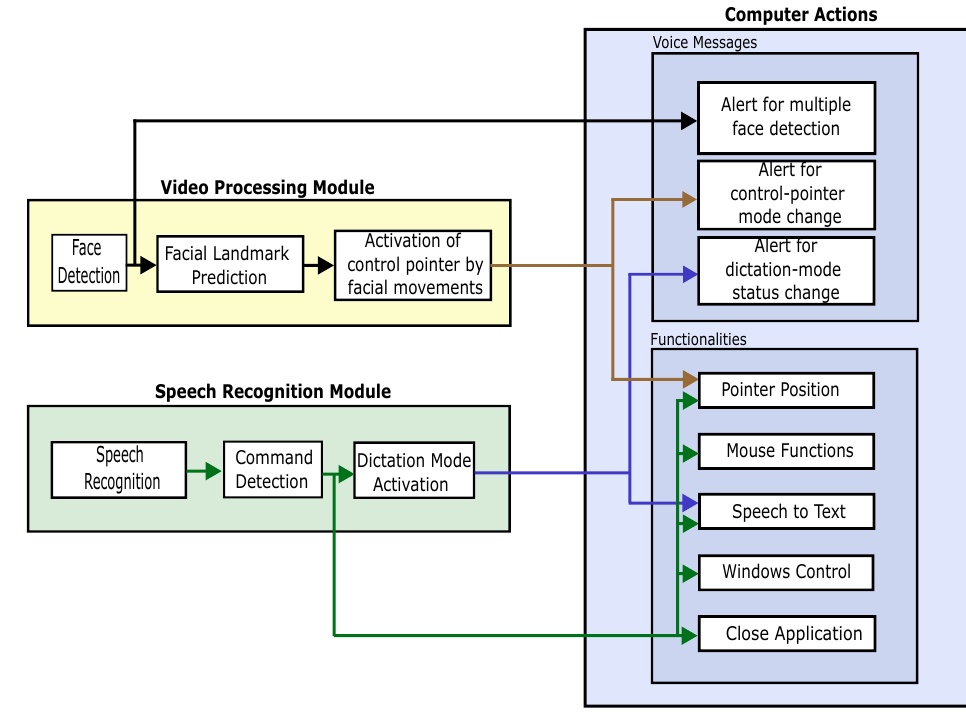
Figure 8. EMKEY module